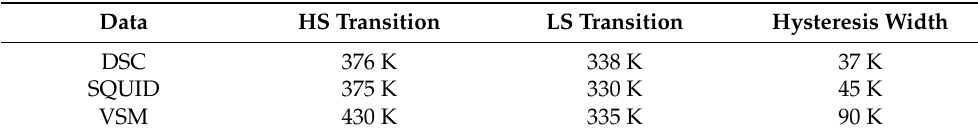
Table 2. Summary and comparison of the data collected for the transitions between low spin state to high spin state and vice versa, between three datasets collected for [Fe(Htrz) 2 (trz)](BF 4 )] nanocubes. Data HS